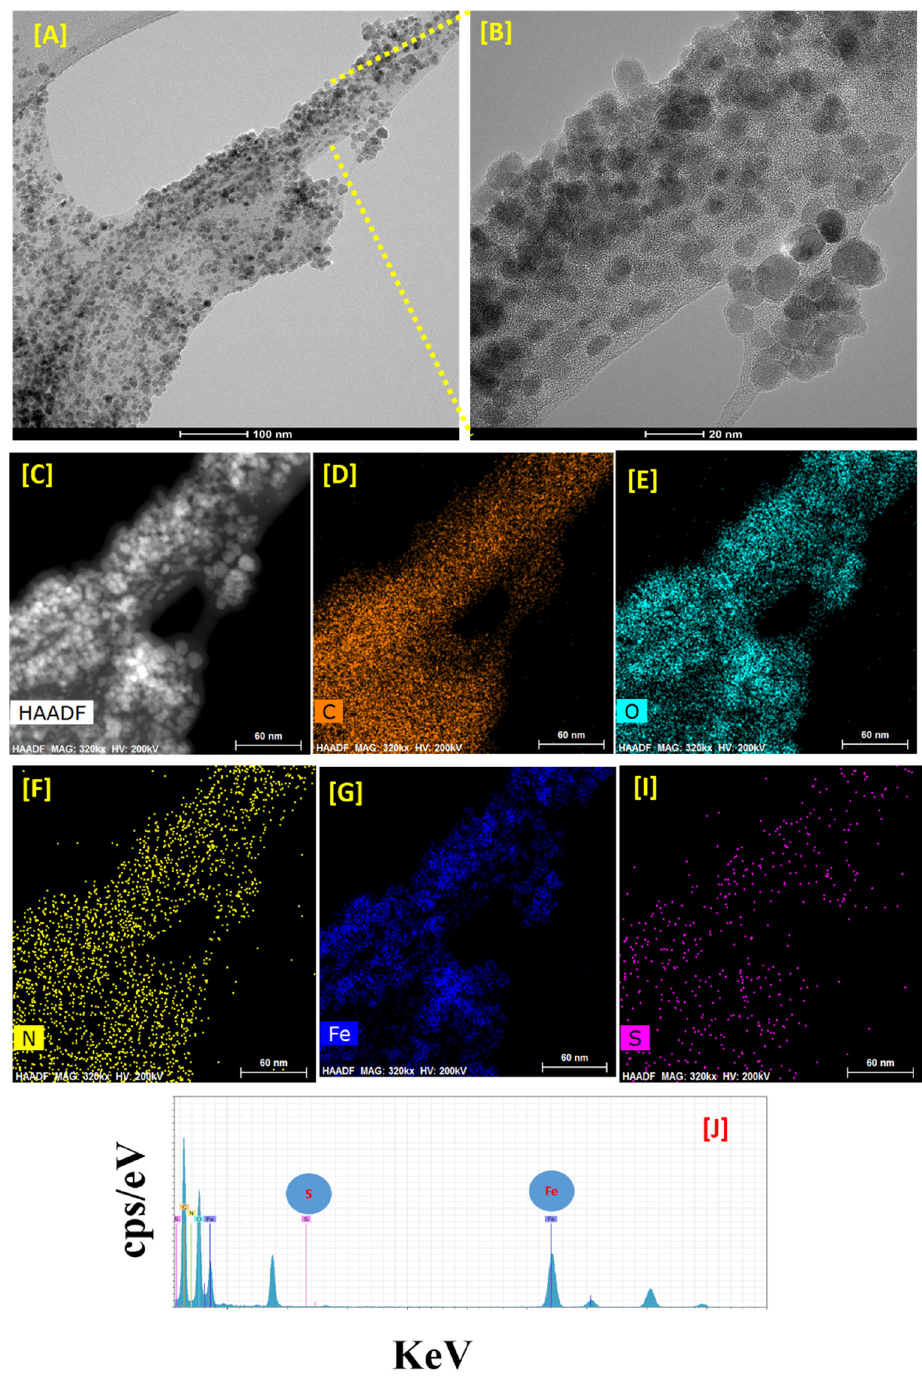
Figure 2. High-resolution transmission electron microscopy (HR-TEM) image of ( A ) α -Cellulose- Fe 3 O 4 -CTNs-SH, ( B ) Zoomed view of the α -Cellulose-Fe 3 O 4 -CTNs-SH HR-TEM image, ( C ) high- angle annular dark-field imaging (HAADF) analysis of the α -Cellulose-Fe 3 O 4 -CTNs-SH, HR-TEM HAADF elemental mapping ( D ) carbon (C), ( E ) oxygen (O), ( F ) nitrogen (N), ( G ) iron (Fe), and ( I ) sulfur (S), and ( J ) HR-TEM EDS profile of the α -Cellulose-Fe 3 O 4 -CTNs-SH. The waste-paper obtained α -cellulose acted as both template and spacer to result in Fe 3 O 4 NPs having narrow distribution, without any undesirable aggregation or